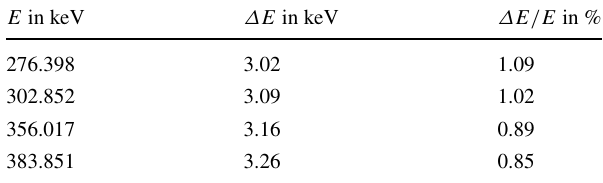
Table 1 Absolute and relative energy resolutions of the pixelated cam- erausedintheComptonScanner,determinedfromeventswiththechar- acteristic 133 Ba gamma energies [31] and only one energy deposition in the camera. The width of the peak, Δ E , corresponds to the